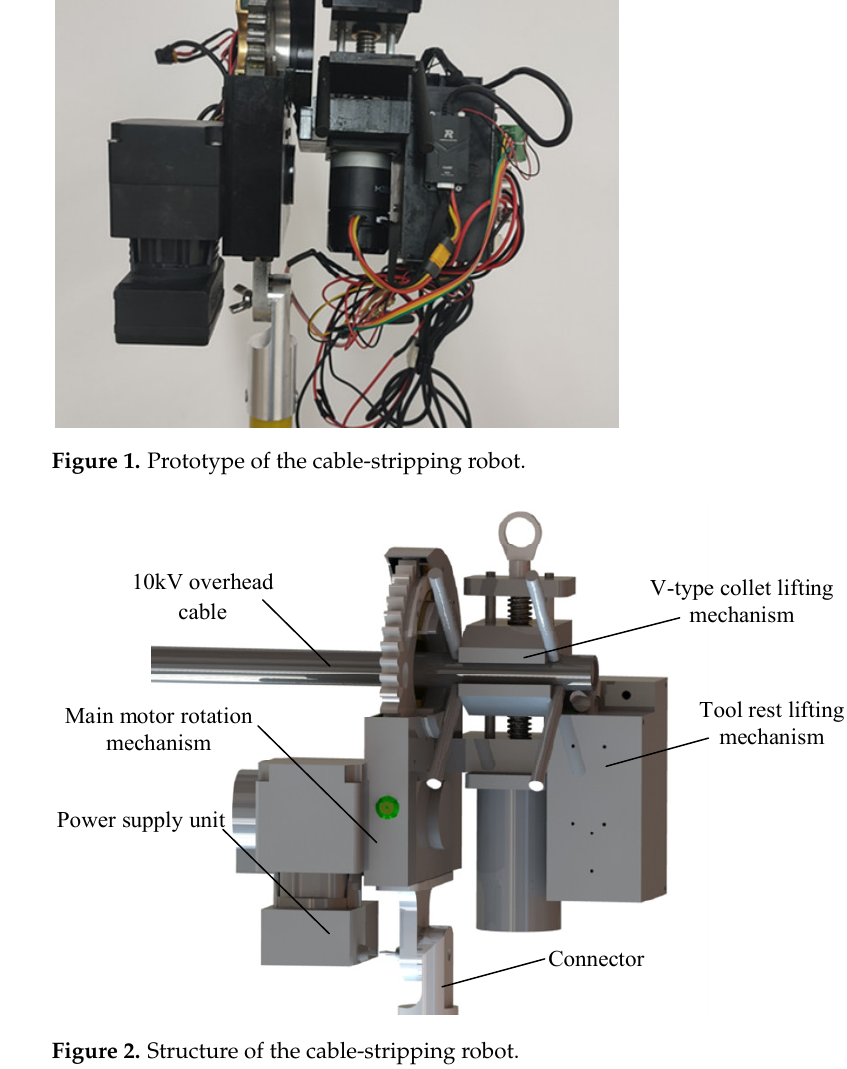
Table 1. Key parameters of the cable-stripping robot.